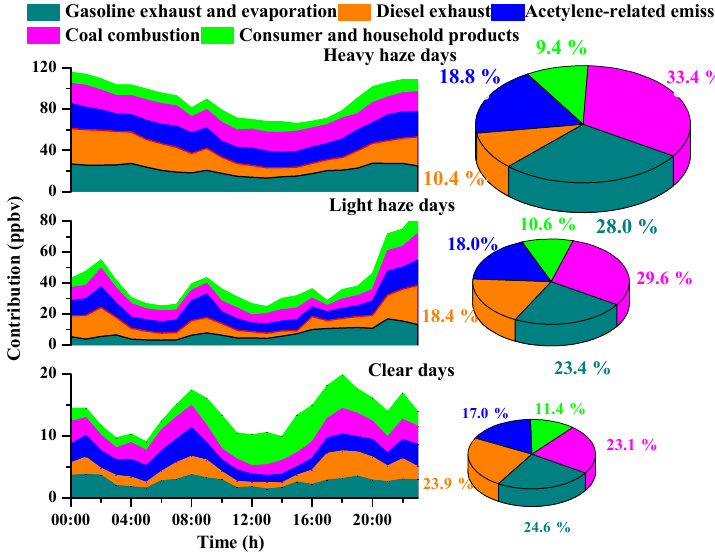
Figure 8. The diurnal variations in the contributions from the five factors to atmospheric NMHCs (left) and source apportionment of NMHCs (right) in Beijing during clear days, light haze days, and heavy haze